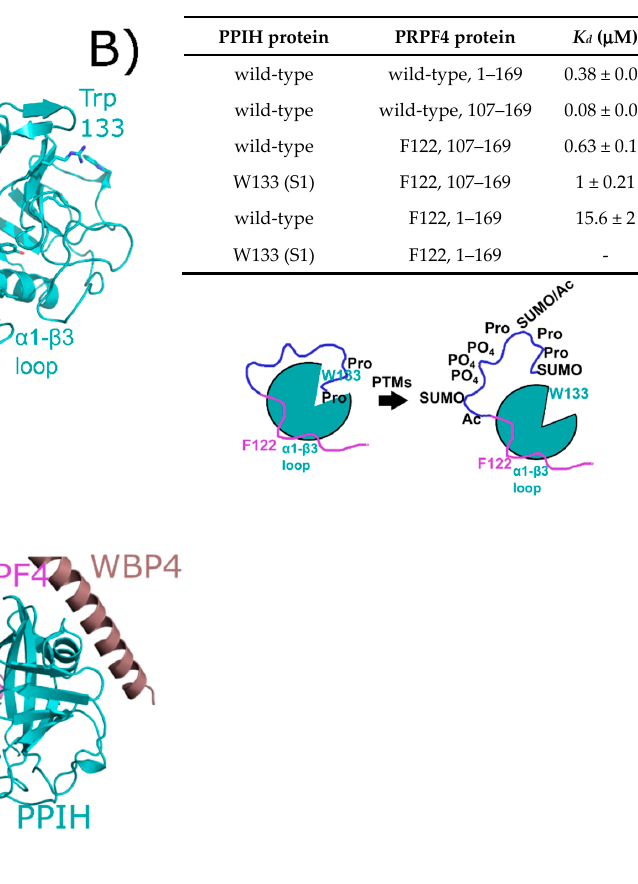
Ubiquitin-Like Modifier.